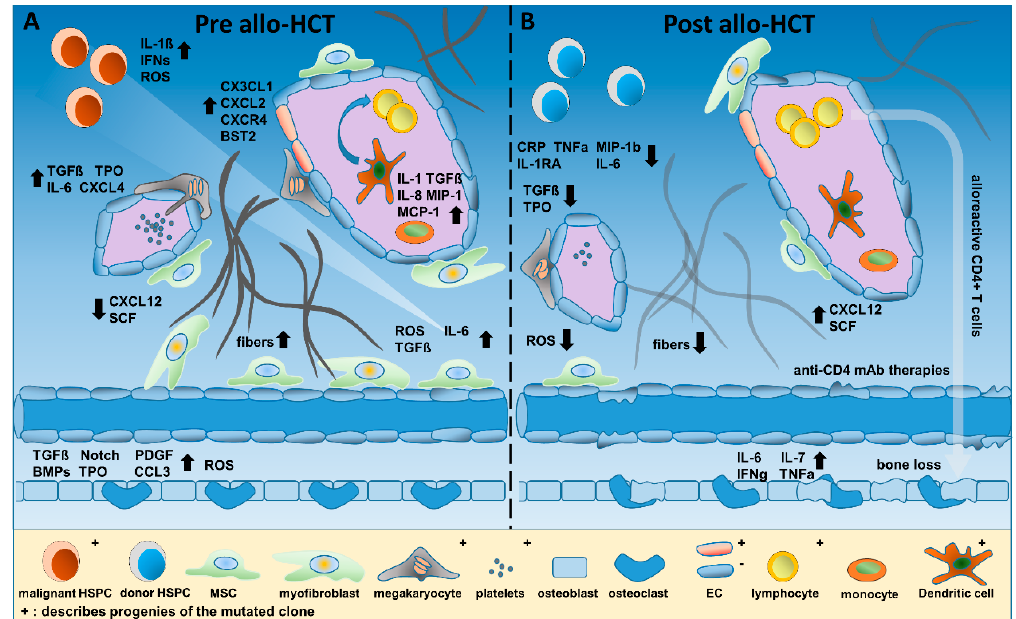
Figure 1. Overview of inflammatory cytokines and their producer cells before and after allogeneic hematopoietic (stem) cell transplantation (allo-HCT). ( A ) The pre allo-HCT microenvironment in myelofibrosis (MF) represents a state of inflammation in the hematopoietic niche of the bone marrow (BM). The malignant hematopoietic stem cells (HSCs), harboring the JAK2V617F, CALR, or MPL oncoprotein, secrete cytokines involved in inflammation, and they differentiate into aberrant hematopoietic progenitors such as megakaryocytes (and platelets), monocytes, dendritic cells, and granulocytes. Together, these cells induce BM stromal cells to secrete fibrogenic cytokines (e.g., TGF β , IL-6, IL-1 β , IL-8, and MIP-1). In addition, endothelial cells (ECs) may harbor driver oncogenes (confirmed for the JAK2V617F mutation), and these malignant ECs were demonstrated to trigger thrombotic events. Mesenchymal stromal cells (MSCs) are recruited to the niche by megakaryocyte-derived CXCL4 and di ff erentiate into myofibroblasts, accelerating fibrosis via reticulin and collagen deposition. This leads to loss of hematopoietic support by the MSCs and subsequent suppression of normal blood cell production. Several cell types generate reactive oxygen species (ROS) in MF, which stimulate the proliferation of the malignant clone, induce DNA double-strand breaks, and correlate with complications in hematopoietic cell transplantation (HCT). ( B ) After conditioning and HCT, the malignant HSCs are depleted, and donor HSCs differentiate and replace aberrant hematopoietic but also certain non-hematopoietic cell types. The result is a reduction of MPN-associated inflammatory cytokines, ROS, and fibrosis and an increase of essential stemness factors, such as CXCL12 and stem cell factor (SCF). Alloreactive CD4+ T cells are involved in the graft-versus-fibrosis effect, but also in bone loss. ECs, osteoblasts, and osteoclasts are harmed in the process of HCT, and data are currently lacking to inform us whether their inflammatory activity is fully reversed. Whether myofibroblasts and mutated ECs undergo apoptosis or senescence after HCT has not yet been elucidated. Tefferi et al. analyzed plasma of 127 PMF patients and confirmed an increase of 19 circulating cytokines in comparison to healthy controls [38]. Among them, interleukin-8 (IL-8), sIL-2R, IL-12, IL-